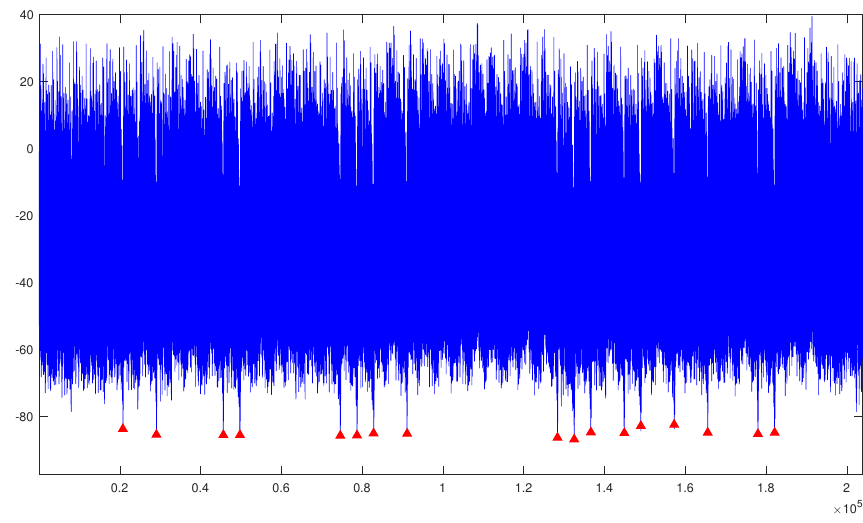
Figure 5. The Average of 10 Power Consumption Traces of Polynomial Multiplication using Grace School Multiplication